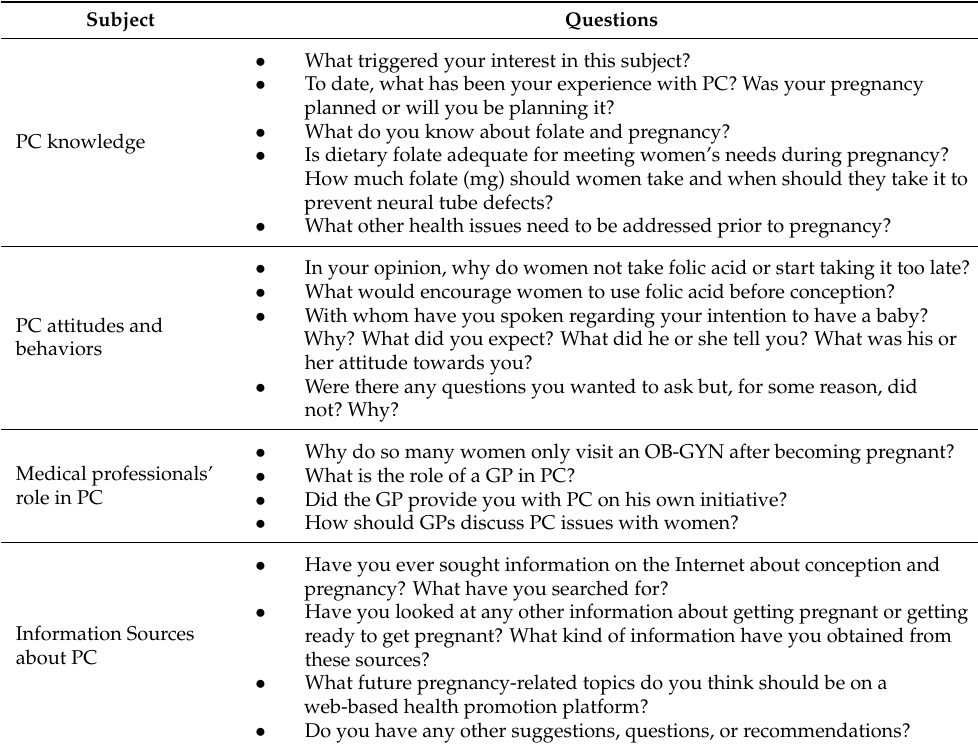
Table 1. List of questions used in the focus